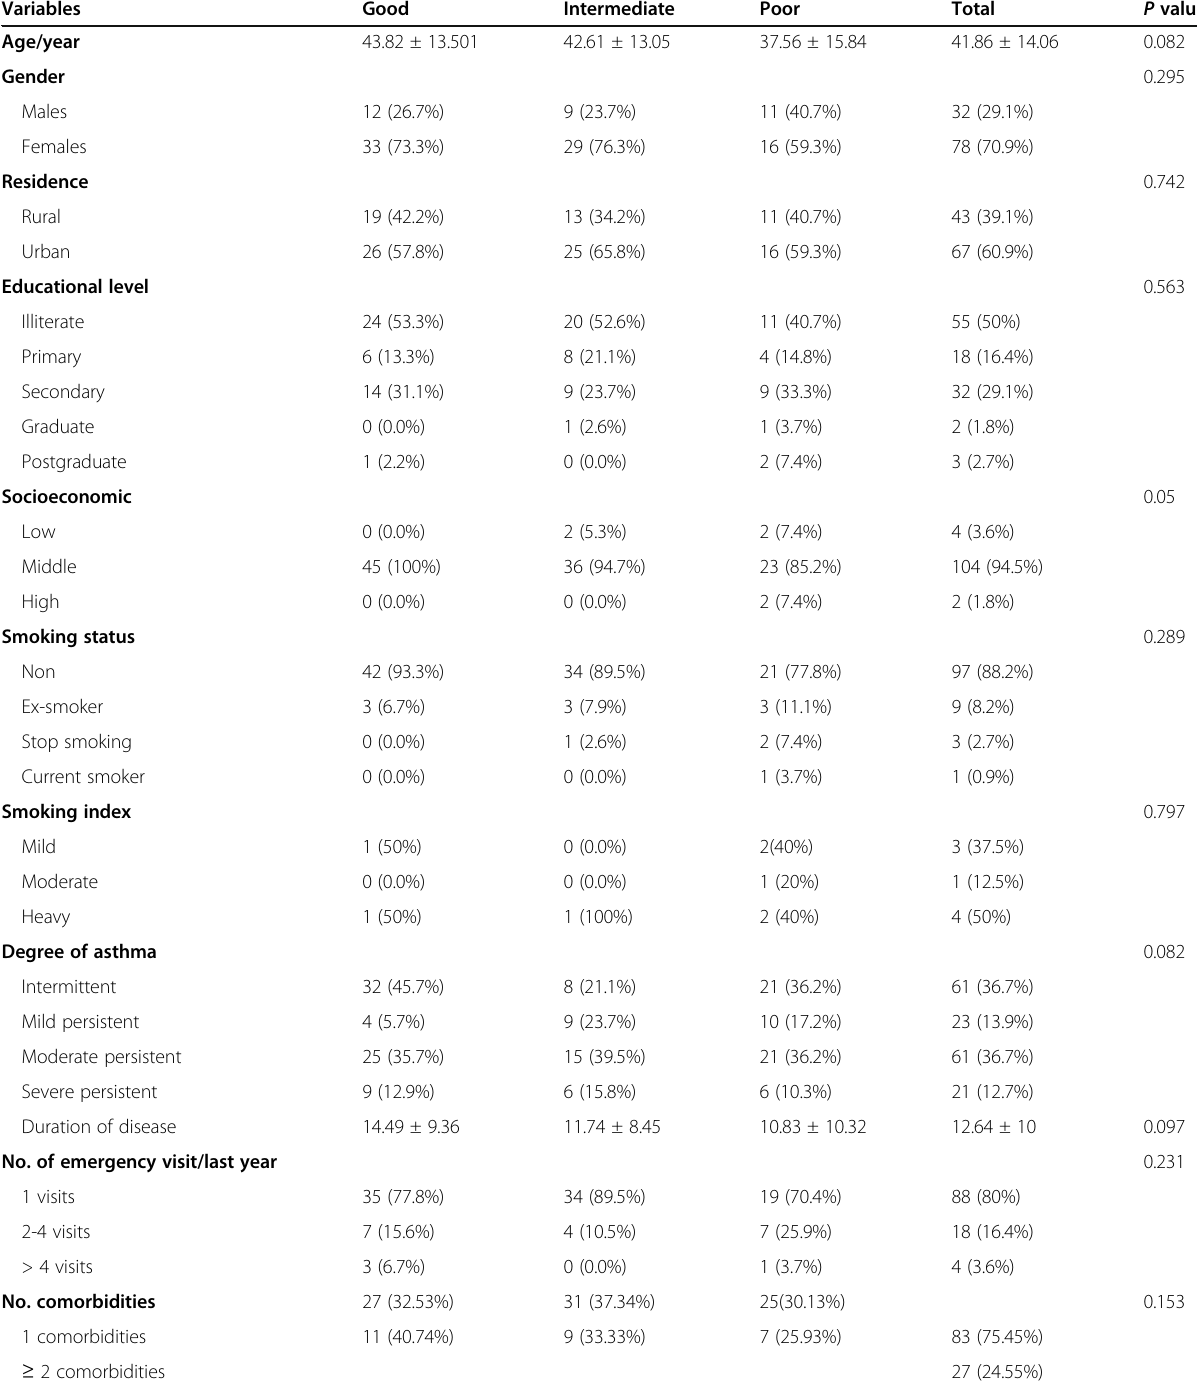
Table 2 Relation between demographic data and adherence pattern in asthmatic patients already on therapy ( n = 110)